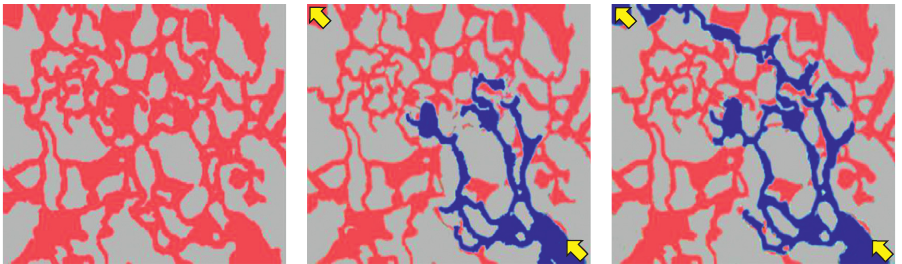
Figure 7: Schematic diagram of the early, middle, and late stages of water injection in a porous-cavernous reservoir.